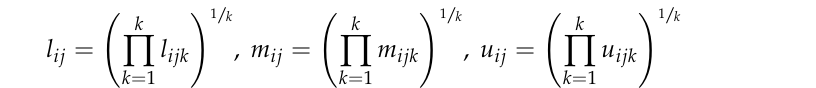
Table 5. The fuzzy pairwise comparison matrix determined for the Ridder–Sokolny mine.